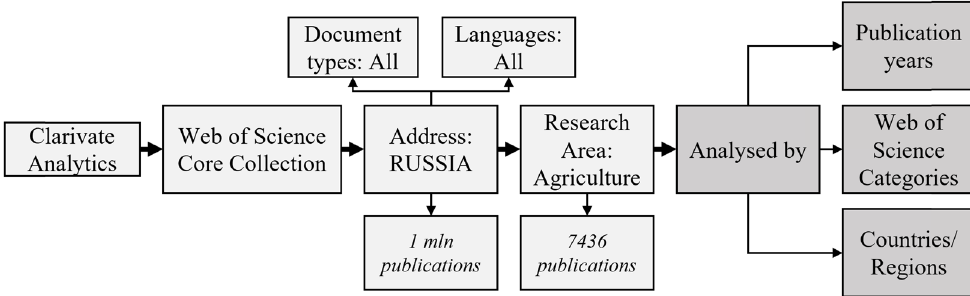
Figure 1: Work fl ow graph for data selection using Clarivate